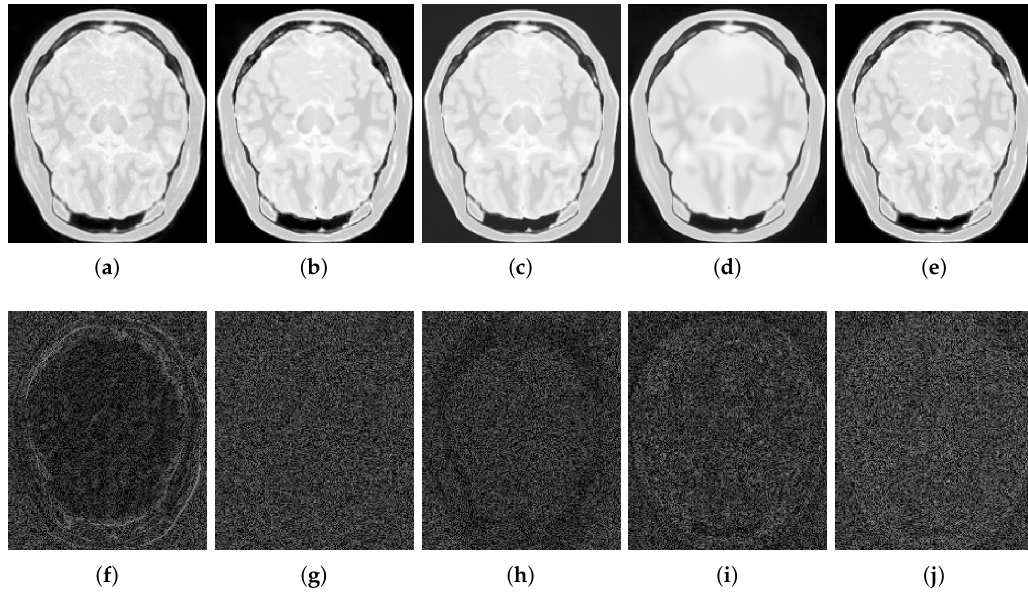
Figure 17. Residuals of the different results produced by the application of the methods evaluated on the noise-free PDw synthetic MR image of Figure 15a corrupted with 5% Rician noise. ( a – e ) are the denoising results of the methods KSVD, PRINLM, BM4D, DNCNN and NLSD, respectively. ( f – j ) are the corresponding residuals.